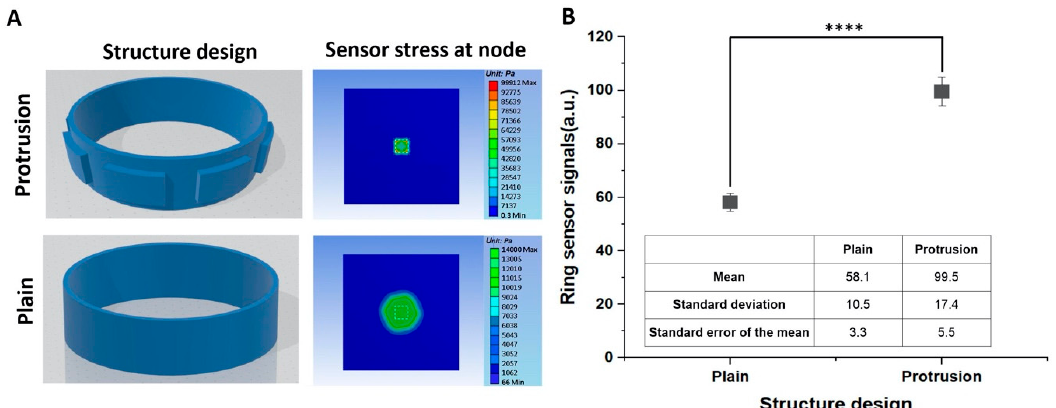
Figure 5. Numerical simulations and experimental results for the effect of the protrusion structure on ring sensor signals ( n = 10). ( A ) Analysis of the finite element simulation of the protrusion and plain structures, where the white dashed line denotes the size of the protrusion. ( B ) The effect of the protrusion structure in comparison to the planar surface, with a p- value of 1.5 × 10 –5 .